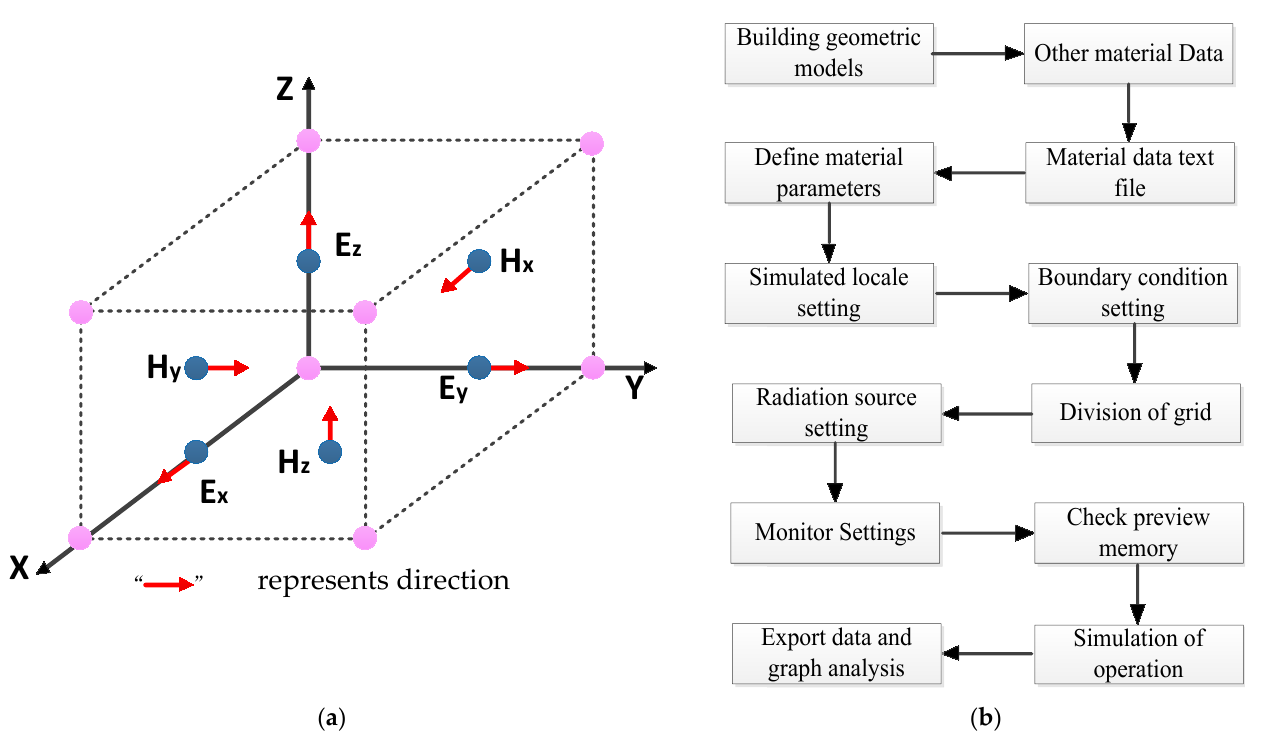
Figure 1 . ( a ) Schematic diagram of FDTD method; ( b ) FDTD running flowchart. Figure 1. ( a ) Schematic diagram of FDTD method; ( b ) FDTD running